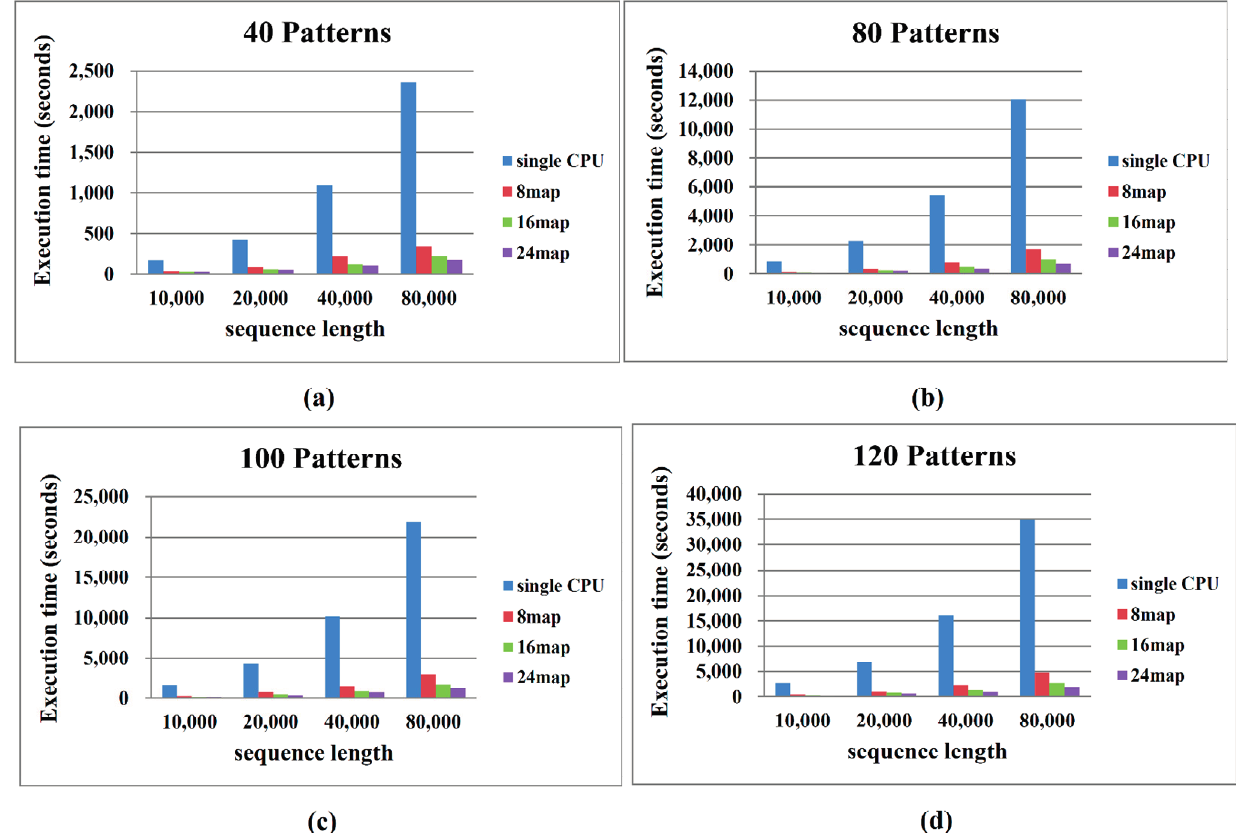
Figure 4. Performance comparison between sequential and MapReduce haplotype block selection (block size = 300 bp). ( a ) Number of Patterns is 40; ( b ) Number of Patterns is 80; ( c ) Number of Patterns is 100 and ( d ) Number of Patterns is